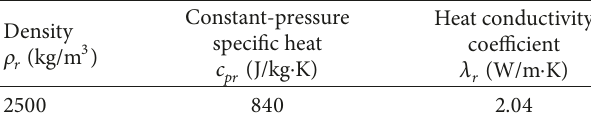
Table 2: Physical properties of surrounding rocks. Density 3 𝜌 𝑟 (kg/m